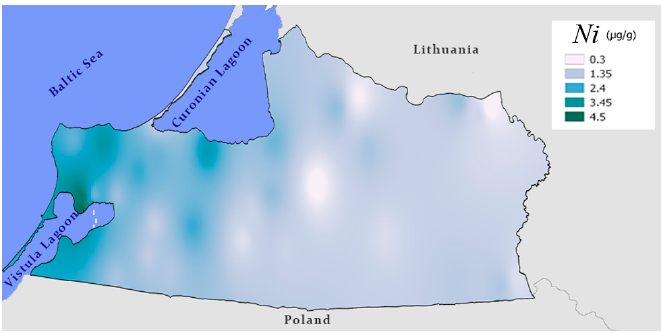
Figure 3. Distribution of nickel in the thalli of H. physodes in the Kaliningrad region, 2010.